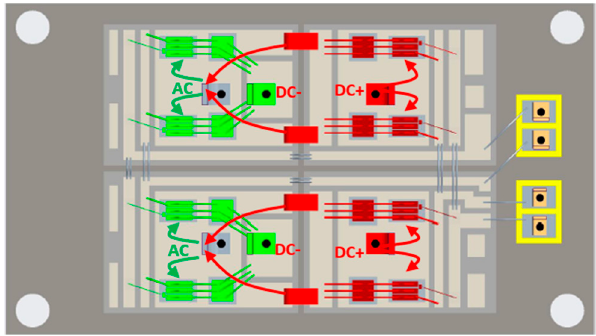
Figure 17. Design of routings inside in module_D (red lines for upper-side; green line for lower-side).